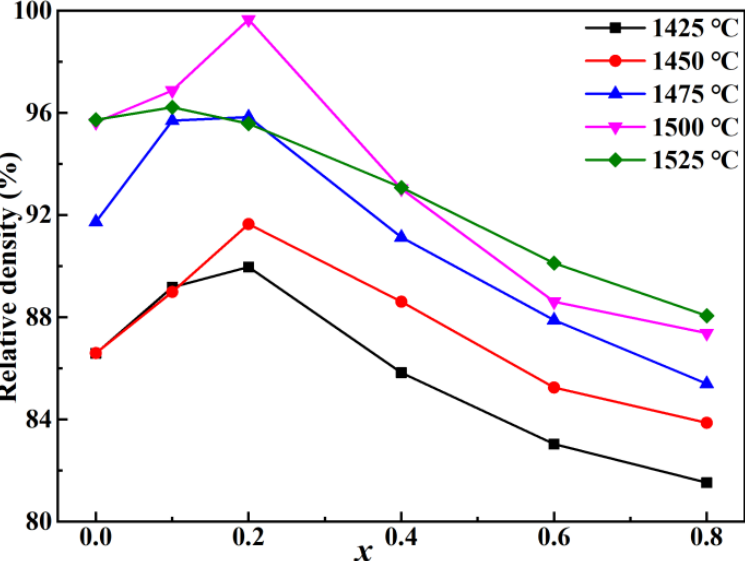
Figure 1. Relative density of Ba x Sr 1 − x (Zn 1/3 Nb 2/3 )O 3 ( x = 0–0.8) ceramics sintered at different temperatures.